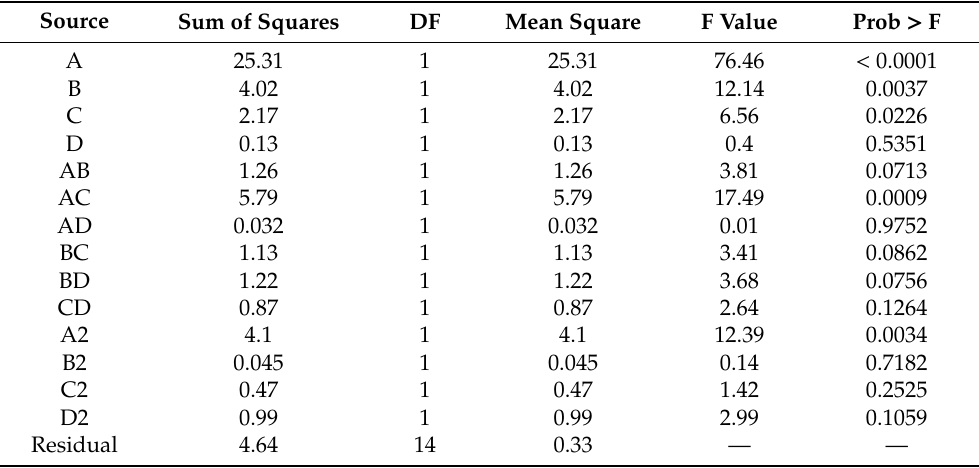
Table 4. The analyses of variance (ANOVA) for carbon yield response surface quadratic